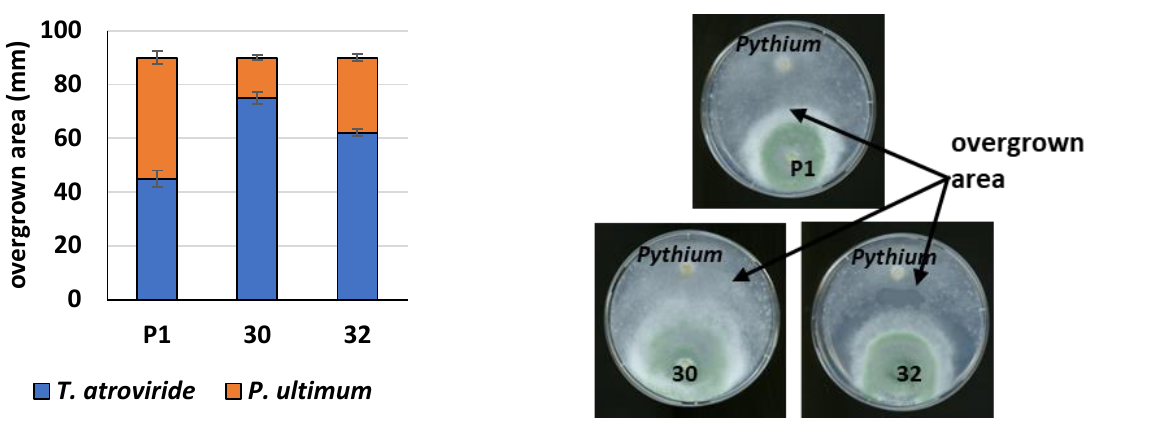
Figure 9. Plate confrontation assay of T. atroviride against P. ultimum . Mycelial disks of RER30/11 (30), RER32/11 (32) transformants and the control strain (P1) and P. ultimum were placed at opposite sides of agar plates and incubated at 28 °C. Pictures were taken three days after inoculation. Arrows mark the overgrown zone between the two fungi. The overgrown zones were measured, and results are presented as mean ± standard deviation from three separate plates. Differences are statistically significant ( p < 0.05; t test).